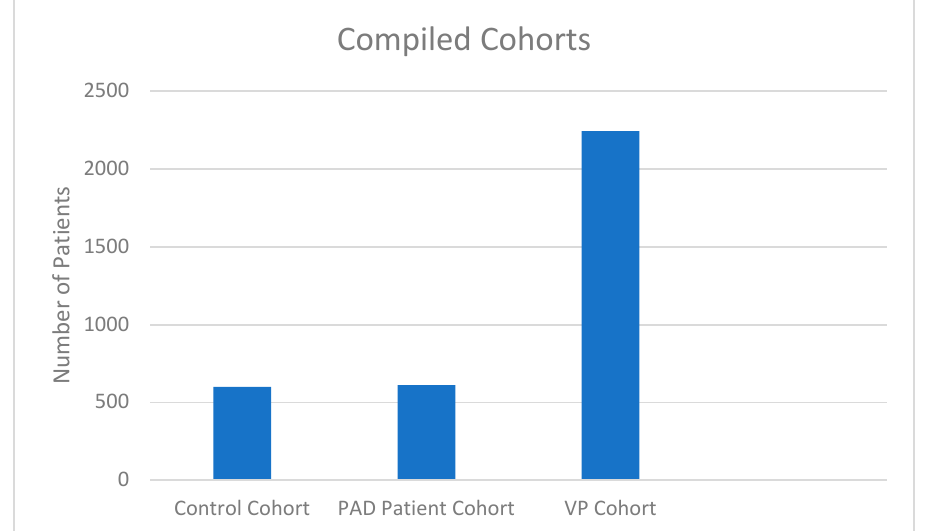
Figure 1. Compiled cohorts. Control cohort: patients with PAD consecutively admitted to our